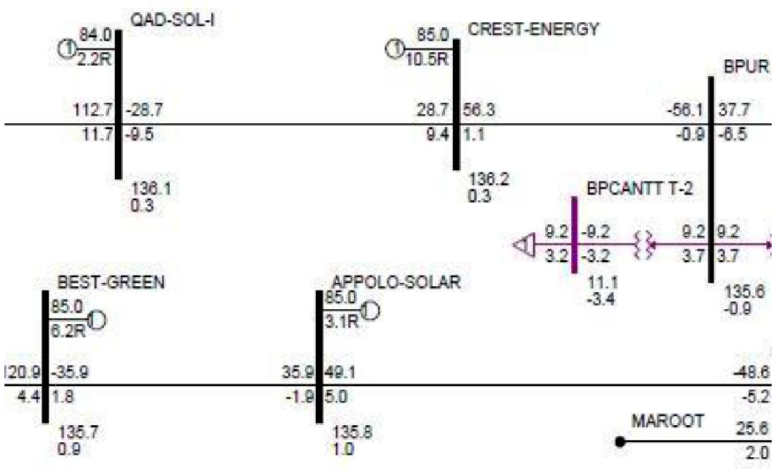
FIG. 7. SOLAR POWER PLANTS